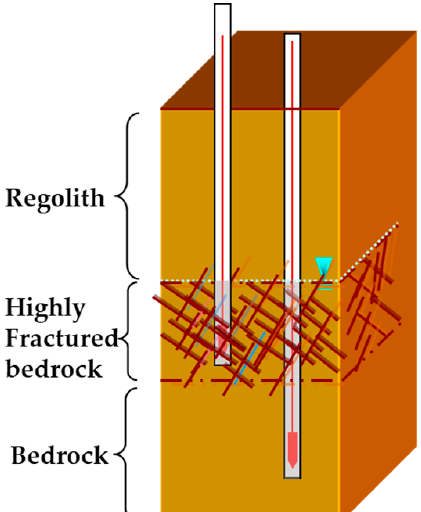
Figure 2. Schematic diagram of a two-level groundwater monitoring system.